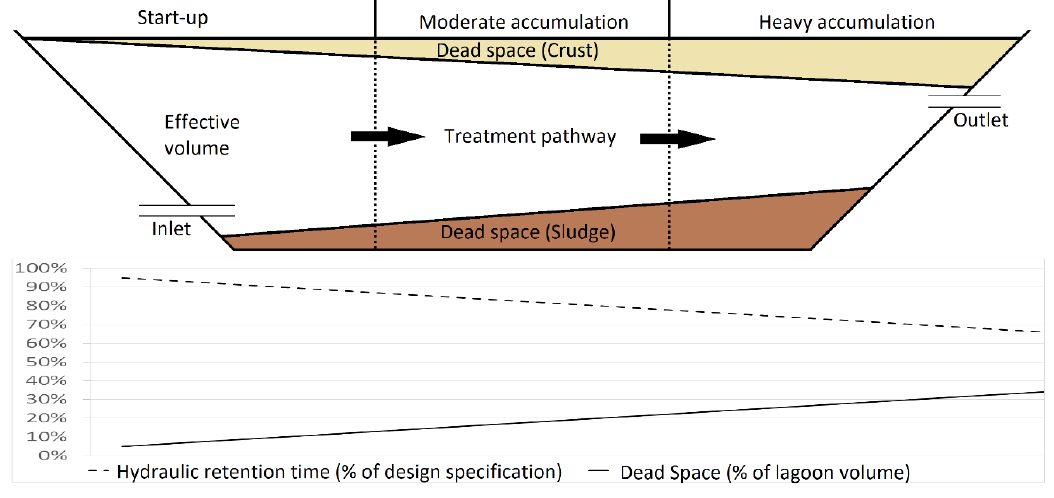
Figure 2. Cross-sectional representation of an anaerobic lagoon accumulating dead space (as crust and sludge) over time and the resulting impact on the effective volume and consequently the coupled parameters of hydraulic retention time and treatment efficiency.